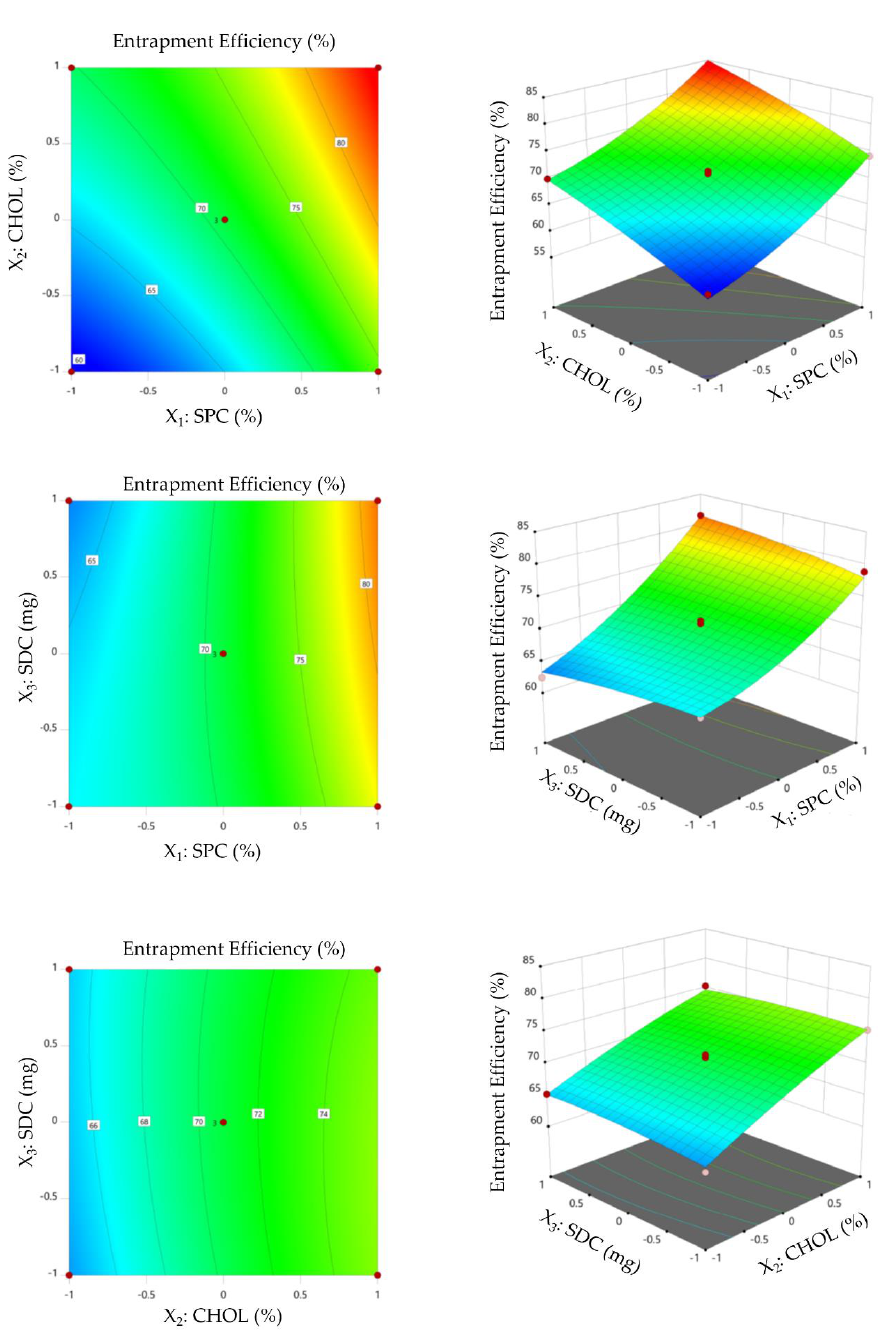
Figure 2. Contour and 3D surface plots showing the influence of formulation variables (SPC, CHOL, and SDC) on entrapment efficiency (%).